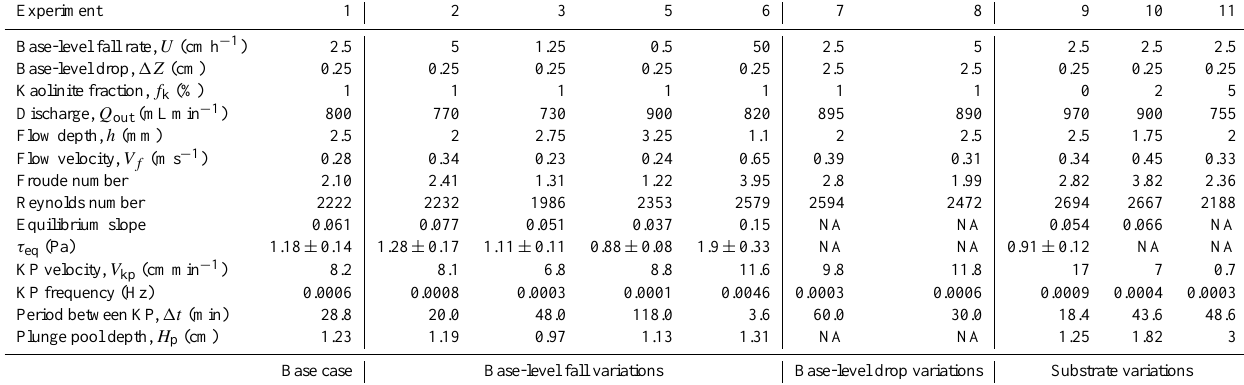
Figure 3. Illustration of a knickpoint observed along the flume during experiment 10. (a) Overall view of the profile and (b, c) details of the knickpoint. Note the white color of the water due to suspended sediments. Table 1. Summary of the main characteristics for each experiments. τ eq represents the equilibrium shear stress. NA stands for no acquisition.